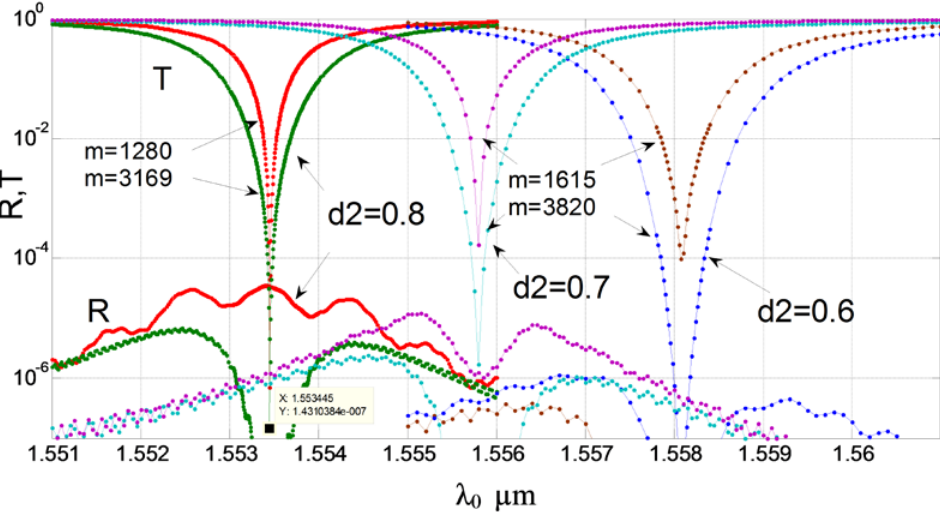
Figure 17. The effect of abnormal blocking for the forward diffraction. The dependence of the transmitting and reflection power of the fundamental mode of the silicon wire on the wavelength for different optimal number of segments ( M = 1280, 3169, 1615 and 3820). Each slope of the walls corresponds to its optimal number of segments and its abnormal blocking wavelength (with d 2 = 0.8 µm, vertical boundaries). Suppression of the transmitting wave is at level of −40 to −60 dB. Analysis made using 2D MoL plus EIM.